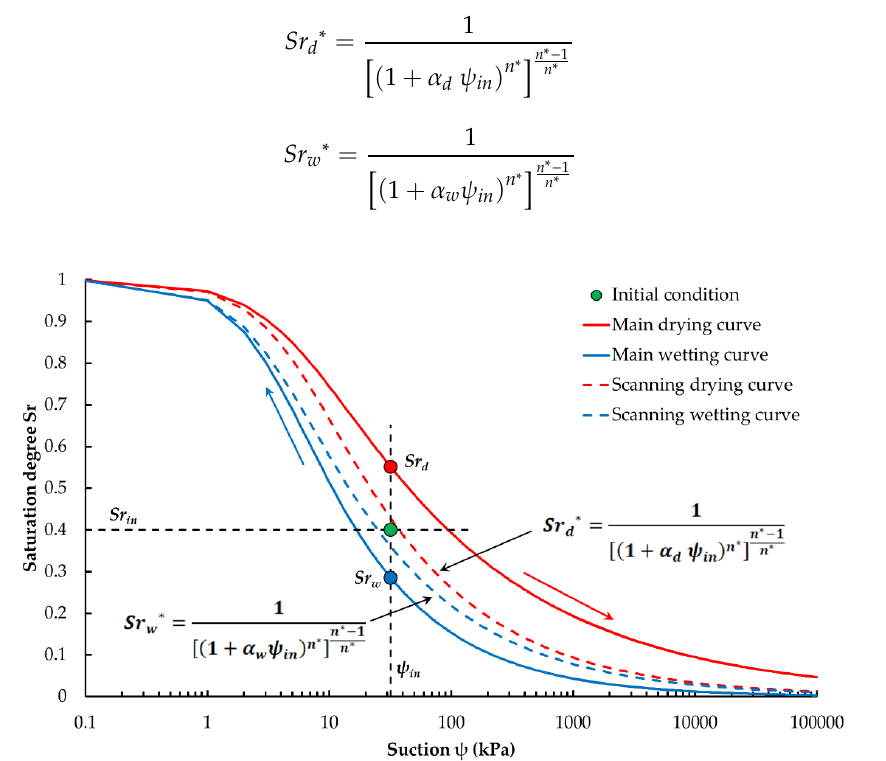
Figure 7. Schematization of the proposed procedure.